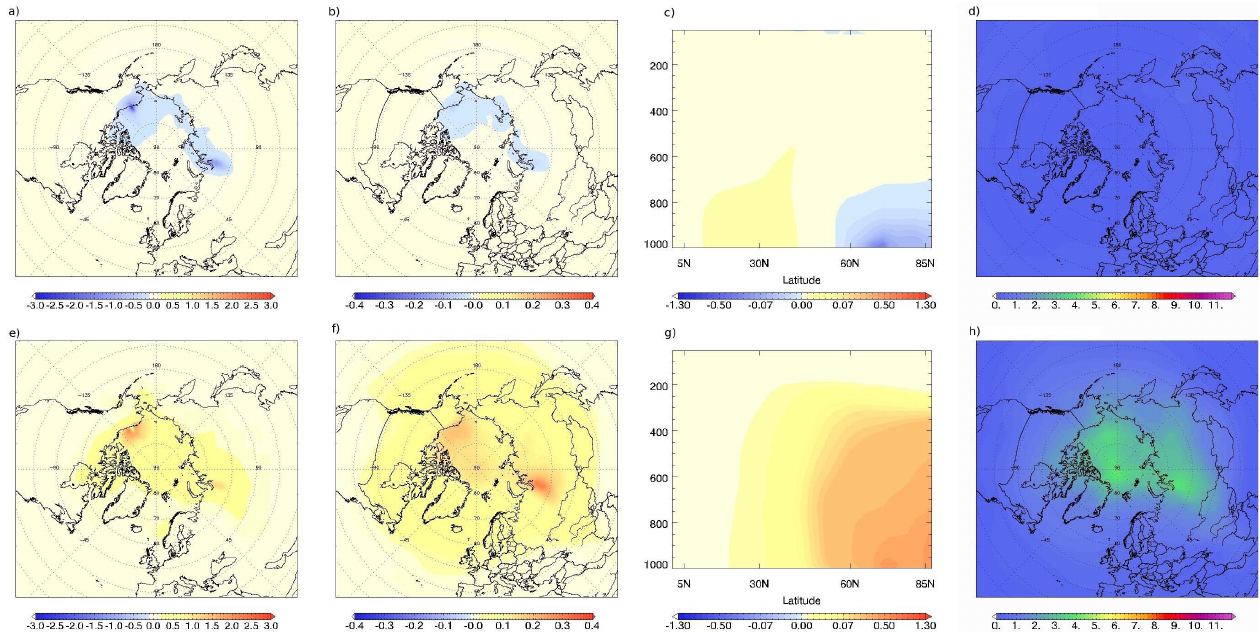
Fig. 4. O 3 effects from Arctic petroleum emissions. Top panel ( a , b , c and d ) are responses from petroleum activity in January-February- March, while lower panel ( e , f , g and h ) are responses for July-August-September. ( a and e ) Seasonal mean contribution to surface O 3 [ppb]. ( b and f ) Seasonal mean impact on tropospheric O 3 column [DU]. ( c and g ) Seasonal zonal mean O 3 [ppb]. ( d and h ) Radiative forcing [mWm − 2 ] due to the ozone changes.